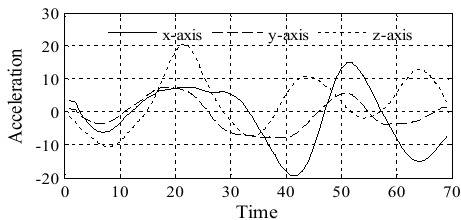
Figure 7. Gesture Data